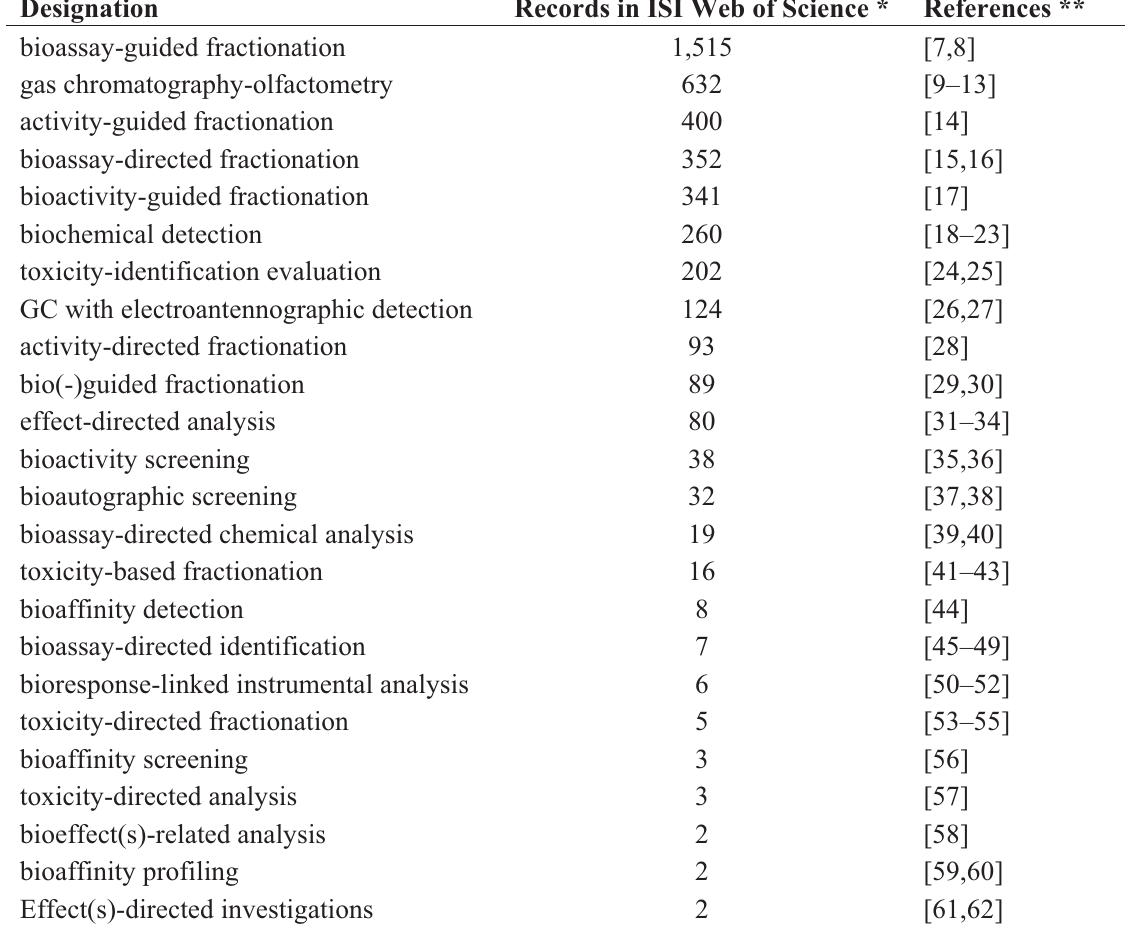
Table 1. Overview of the nomenclature and their use in the